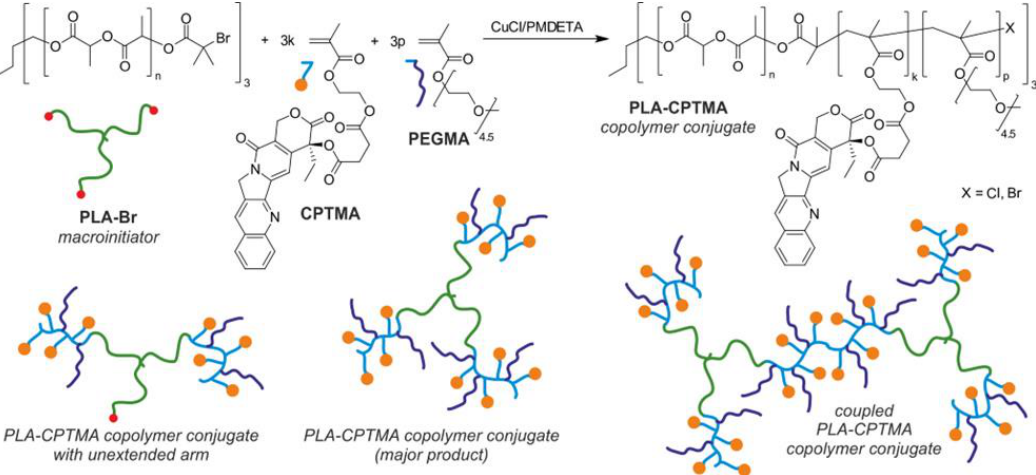
Figure 15. Synthesis of conjugates of PLA and CPT block copolymers proposed by Plichta et al. [281]. Reprinted with permission from Plichta, A.; Kowalczyk, S.; Kamiński, K.; Wasyłeczko, M.; Więckowski, S.; Olędzka, E.; Nałęcz -Jawecki, G.; Zgadzaj, A.; Sobczak, M., ATRP of Methacrylic Derivative of Camptothecin Initiated with PLA toward Three-Arm Star Block Copolymer Conju- gates with Favorable Drug Release. Macromolecules 2017, 50 (17), 6439 – 6450, DOI: 10.1021/acs.mac-